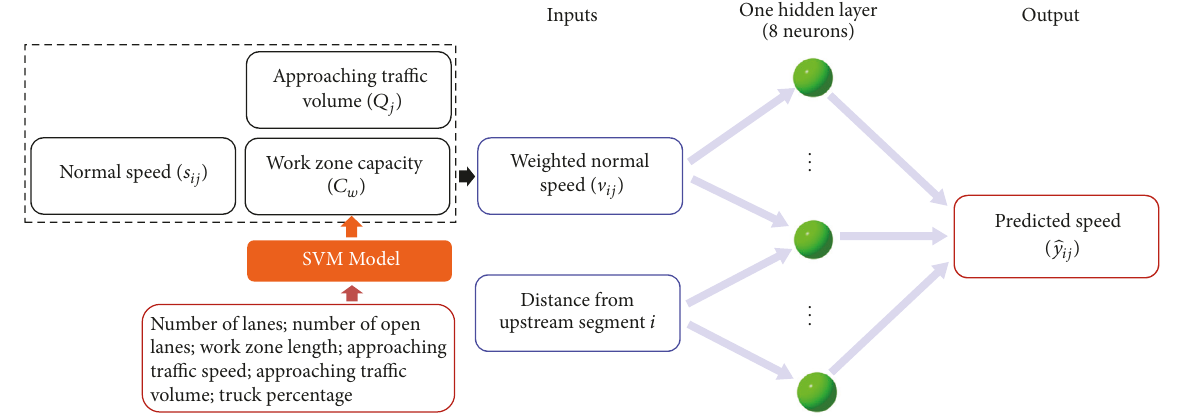
Figure 2: Configuration of the proposed hybrid model.